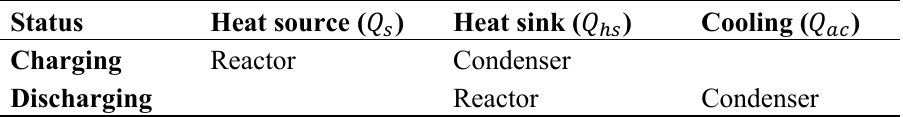
Table 1. System connections to the surroundings depending on